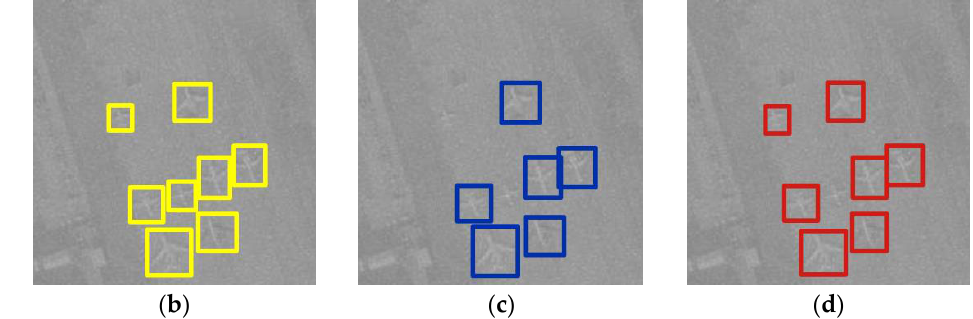
Table 1. Ablation experiments of our proposed method. The bold highlights the best performance.